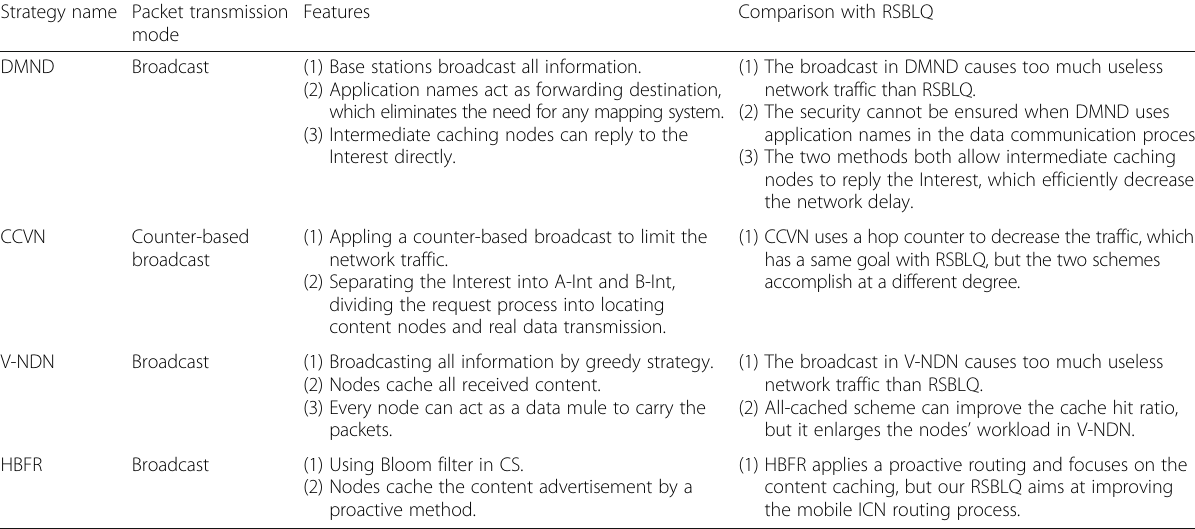
Table 1 The comparison of previous schemes Strategy name Packet transmission mode